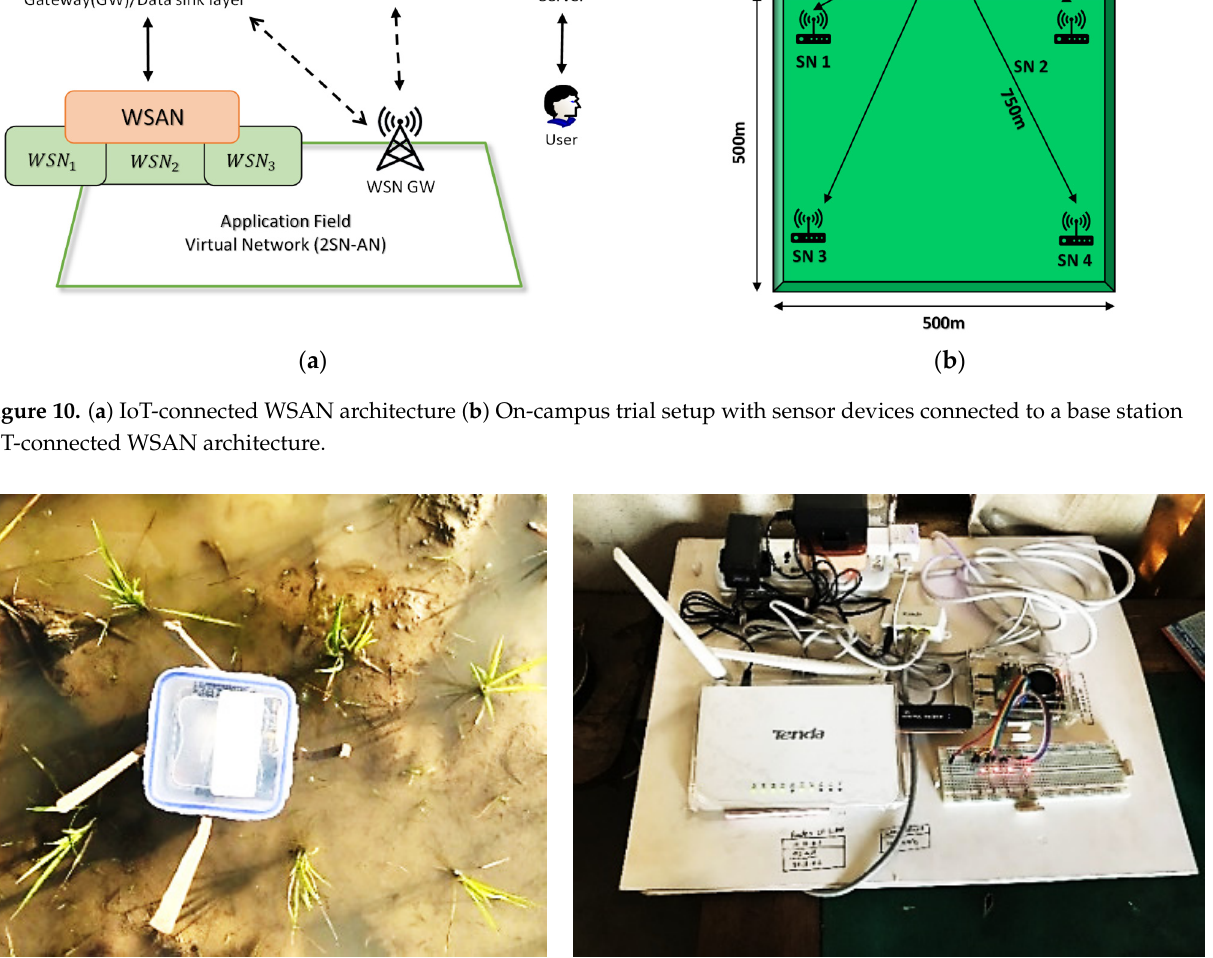
( c ) Figure 12. ( a ) Mobile Application, ( b ) Web Application, and ( c ) client-server connectivity for user interface. The mobile and web applications were linked to a Node.js server. A mobile Android application was used to collect data, a server was used to store the data and generate no- tifications, and a web client was used as a dashboard to display all the AWD specific in- formation. The mobile app and web dashboard used rESTful APIs, HTTP requests, and